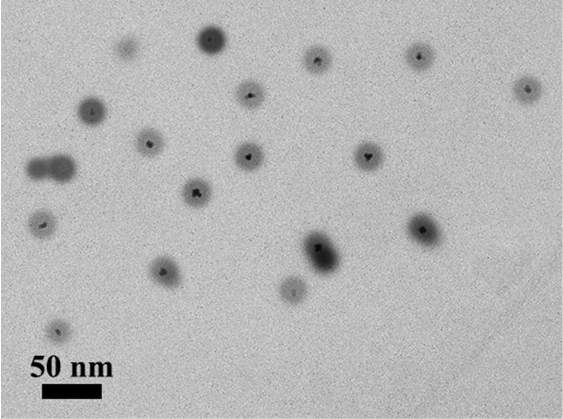
Figure 10. TEM images of CdSe / ZnS@P(MQ-co-St)-b-P(NIPAM-PVK) hybrid